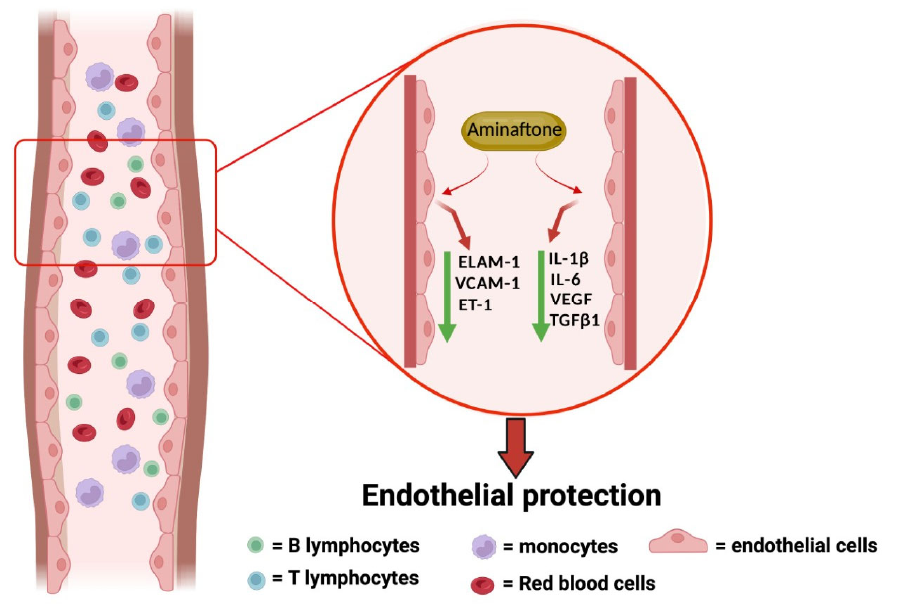
Figure 2. Suggested biological effects of Aminaphtone. Produced at www.biorender.com (accessed on 7 April 2023).